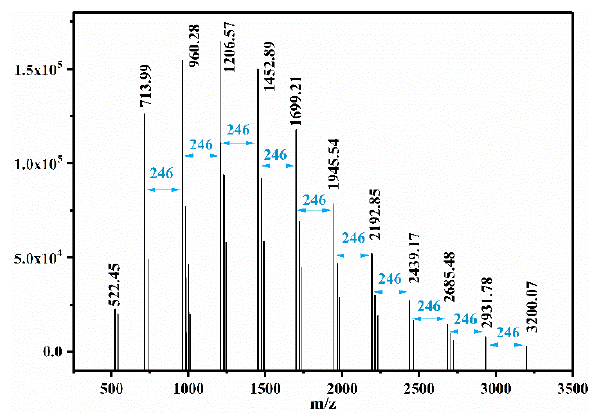
Figure 2. MALDI-TOF-MS spectrum of polyurea.